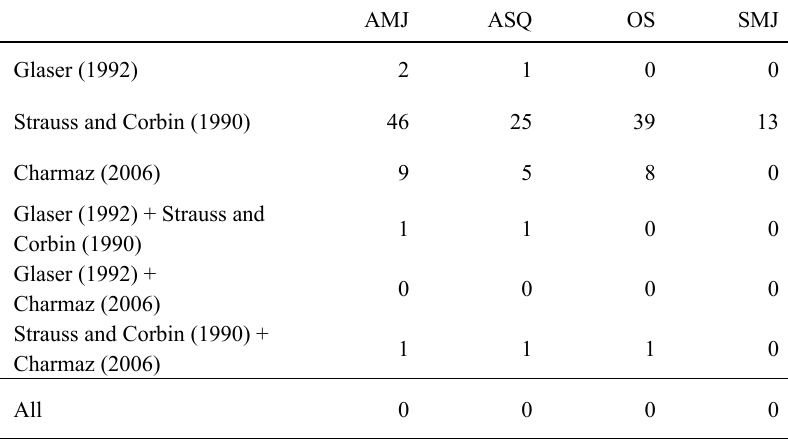
Table 1. Citation in major management journals